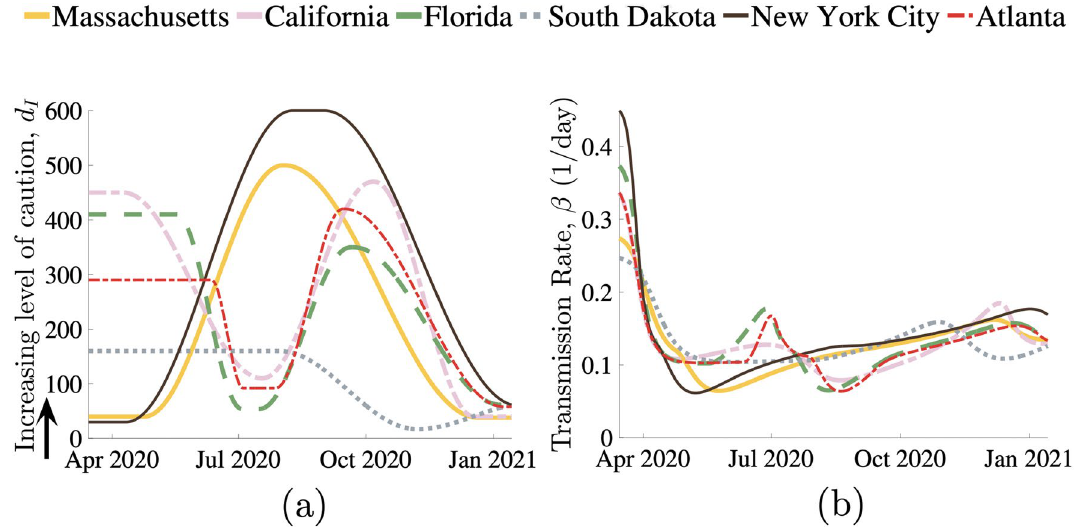
Figure 2. ( a ) Level of caution factor d I and ( b ) disease transmission rate β over the course of COVID-19 in six populations across the United